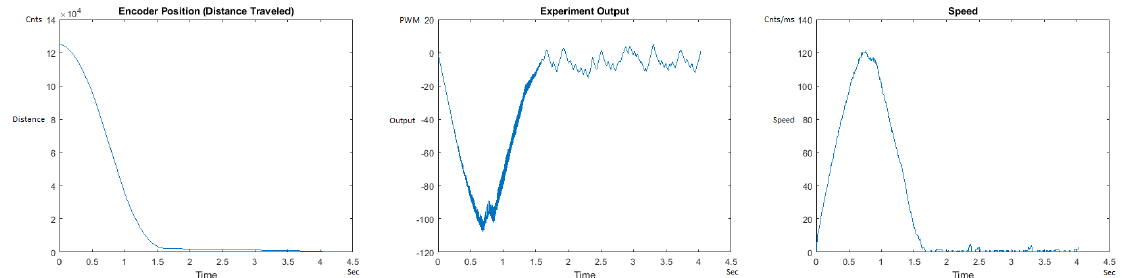
Figure 30. Encoder position, output and speed plots for PID++ DOWN operation— Vmax 120 cnts/ms, Adesired 0.040 cnts/ms 2 —1 Kg.